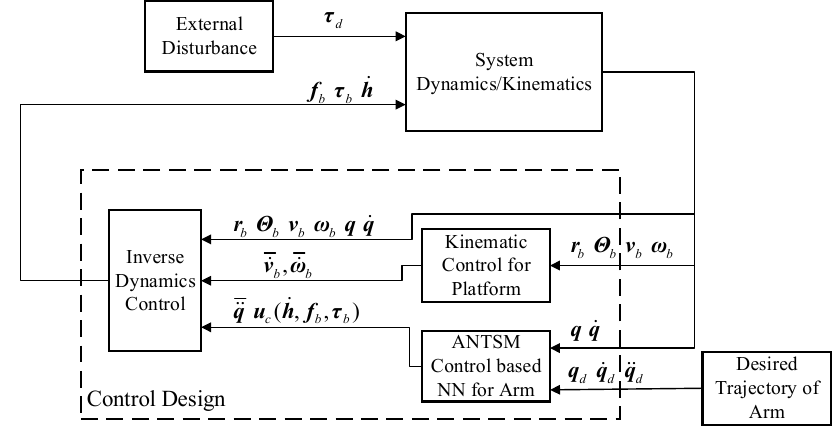
Figure 2. Block diagram of the closed-loop control system.